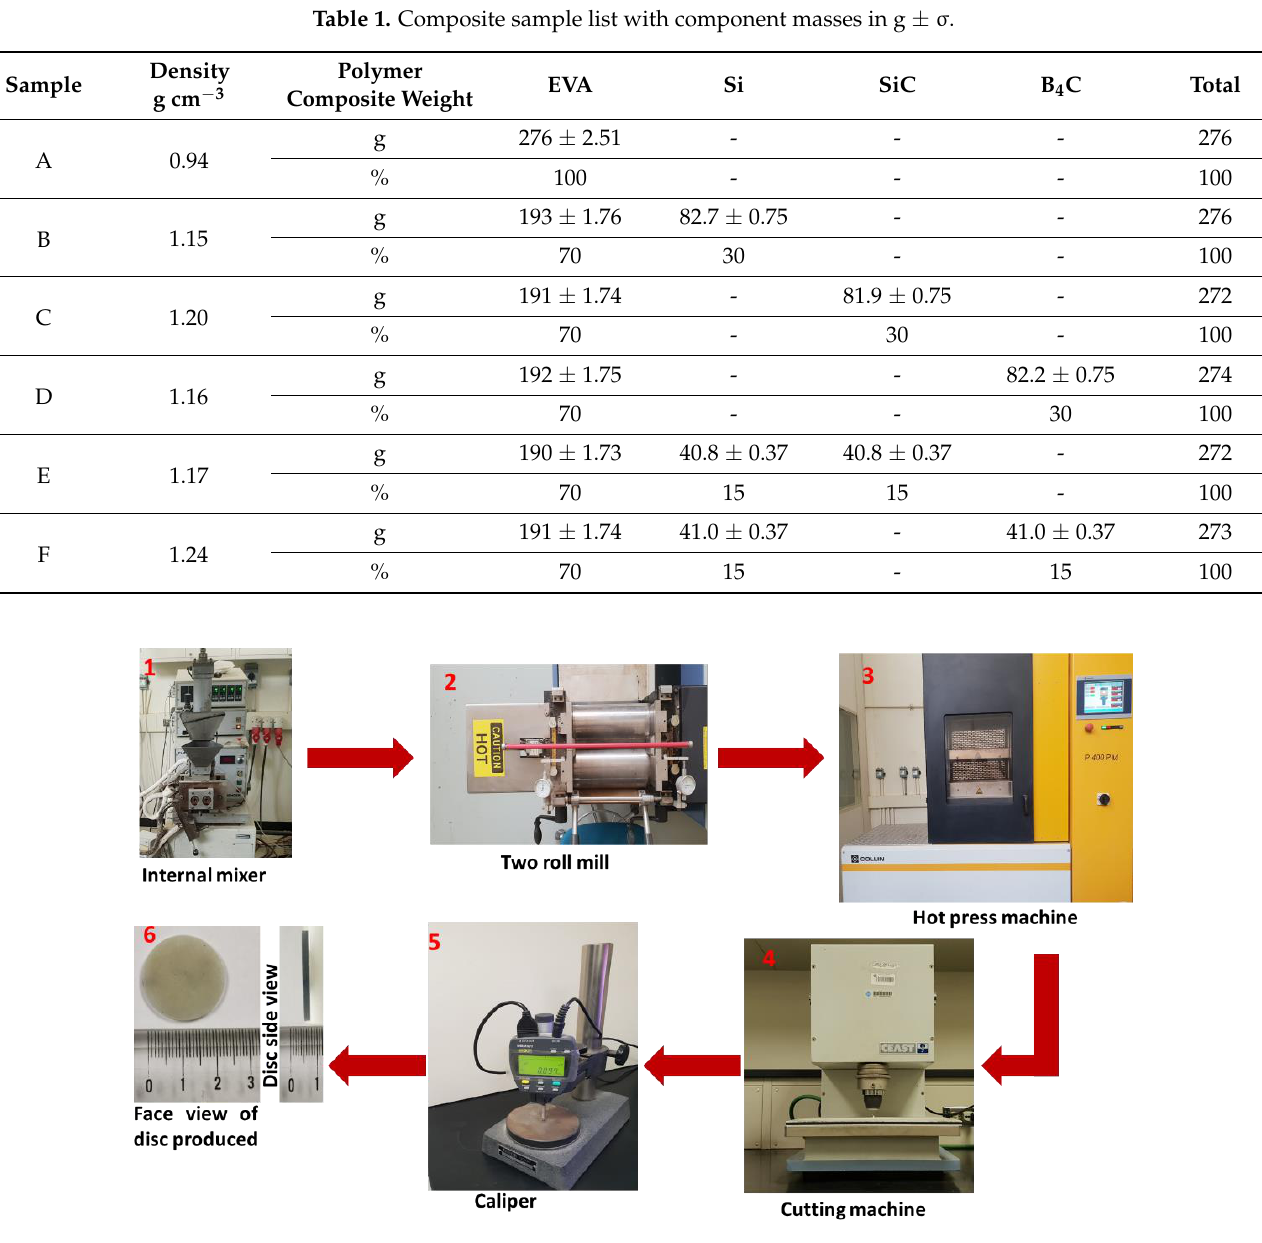
Figure 1. Demonstration of the composites based on a EVA polymer production procedure in the form of discs; the discs produced had a diameter of 25 mm and thickness of 2 mm.